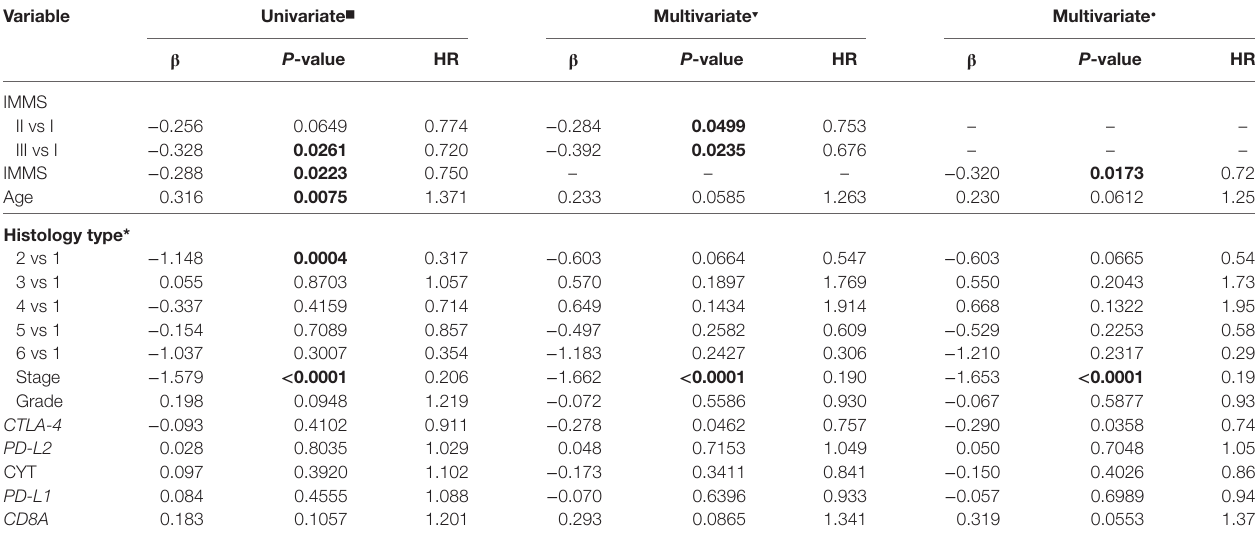
Table 2 | Univariate and multivariate cox regression analyses of disease-free survival for clinical characteristics and immune checkpoint blockade-related genes.